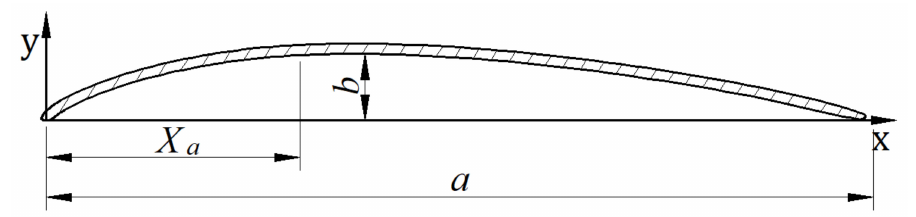
Figure 7. Thin-plate arc